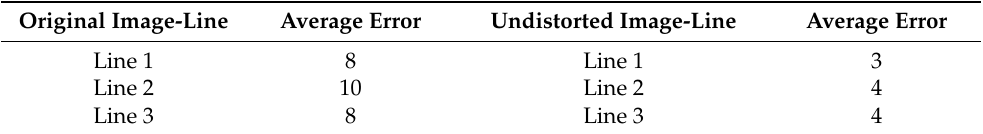
Figure 21. The error between lines and vertex of diamonds based on distortion calibration: ( a ) Rectify of the original image, ( b ) rectify of the calibrated image, ( c ) lines that are made using diamonds on the original image, and ( d ) lines that are made using diamonds on the calibrated image. Table 4. The error between lines using diamonds and vertex before and after distortion calibration.